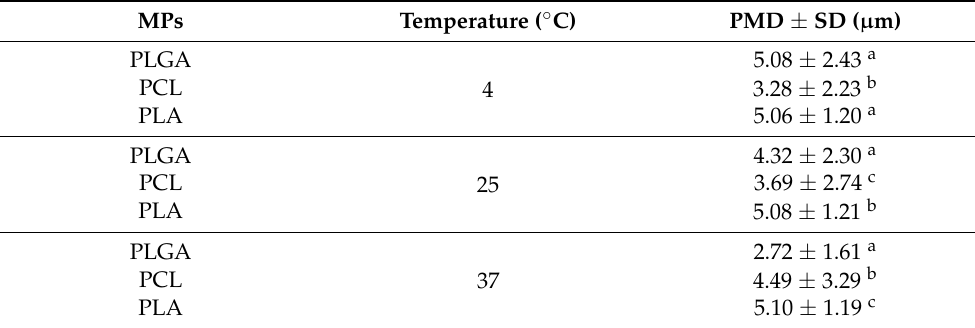
Table 2. PMD of PLGA, PCL, and PLA MPs stored at different temperatures. Different letters (a, b, and c) reported in the PMD column refer to statistically significant differences among the three different samples considered at the same temperature ( p < 0.05), using ANOVA with Tukey’s HSD post hoc multiple comparison test. Results are expressed as mean value ± standard deviation ( n = 3). MPs: microparticles, PMD: particle mean diameter, SD: standard deviation, PLGA: poly(lactic- co -glycolic acid), PCL: poly( ε -caprolactone), PLA: poly(lactic